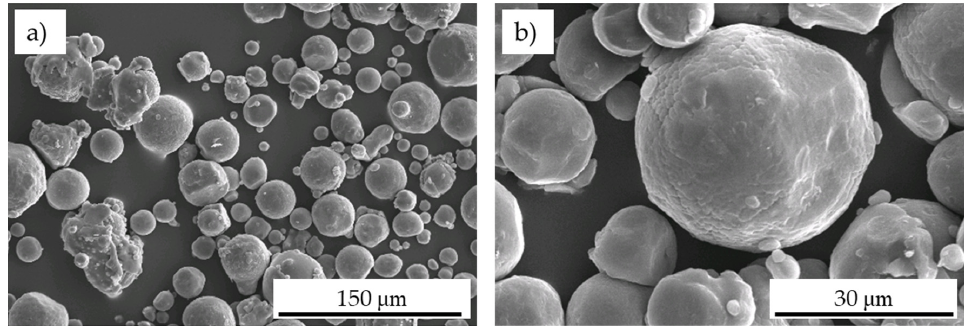
Figure 2. Scanning electron microscopy (SEM) images of AlMgSc alloy powders (a), detail at higher magnification (b). magnification ( b